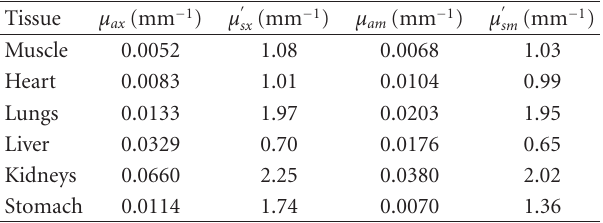
Table 1: Optical parameters of the mouse